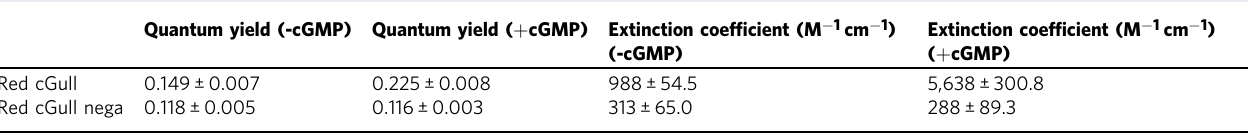
The quantum yields were measured by the absolute photoluminescence quantum yield measurement system (Hamamatsu Photonics, C9920-02). Data were shown as means±standard deviation ( n = 3). The extinction coef fi cients were calculated using absorbance at 562nm (Fig. 2b). Data were shown as means±standard deviation ( n = 4).